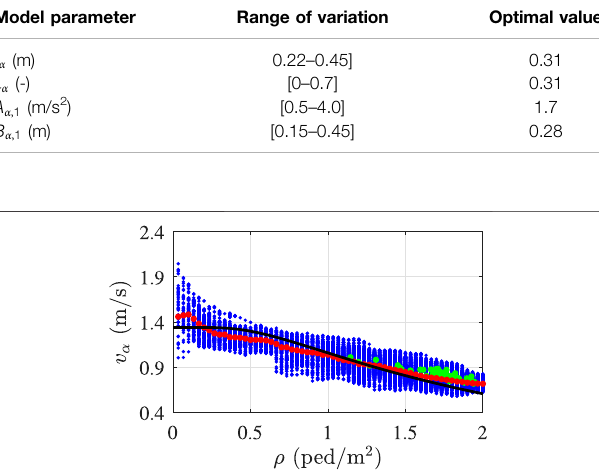
Frontiers in Built Environment |